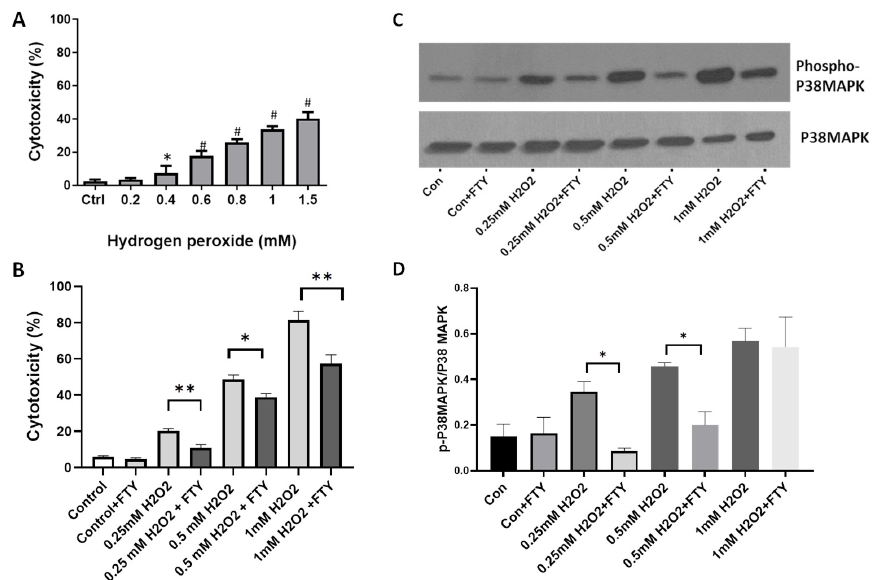
Figure 7. Fingolimod attenuates H 2 O 2 -induced cellular damage and stress signaling in R28 cells. ( A ) LDH assay results showing the dose-dependent effect of H 2 O 2 treatment on R28 cells. * p < 0.05 vs control; # p < 0.01 vs. control and n = 3. ( B ) LDH assay showing the cytotoxic effect of H 2 O 2